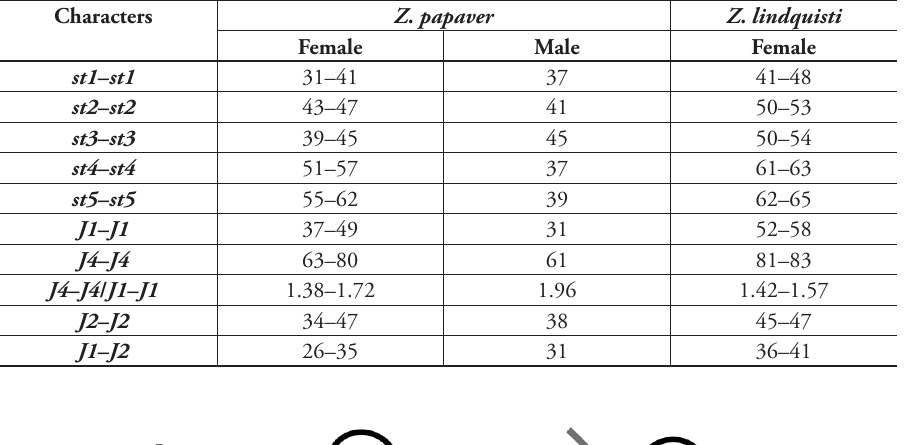
Table 2. Distances between pairs of some dorsal and ventral idiosomal setae of Zygoseius papaver sp. n. and Z. lindquisti sp. n.